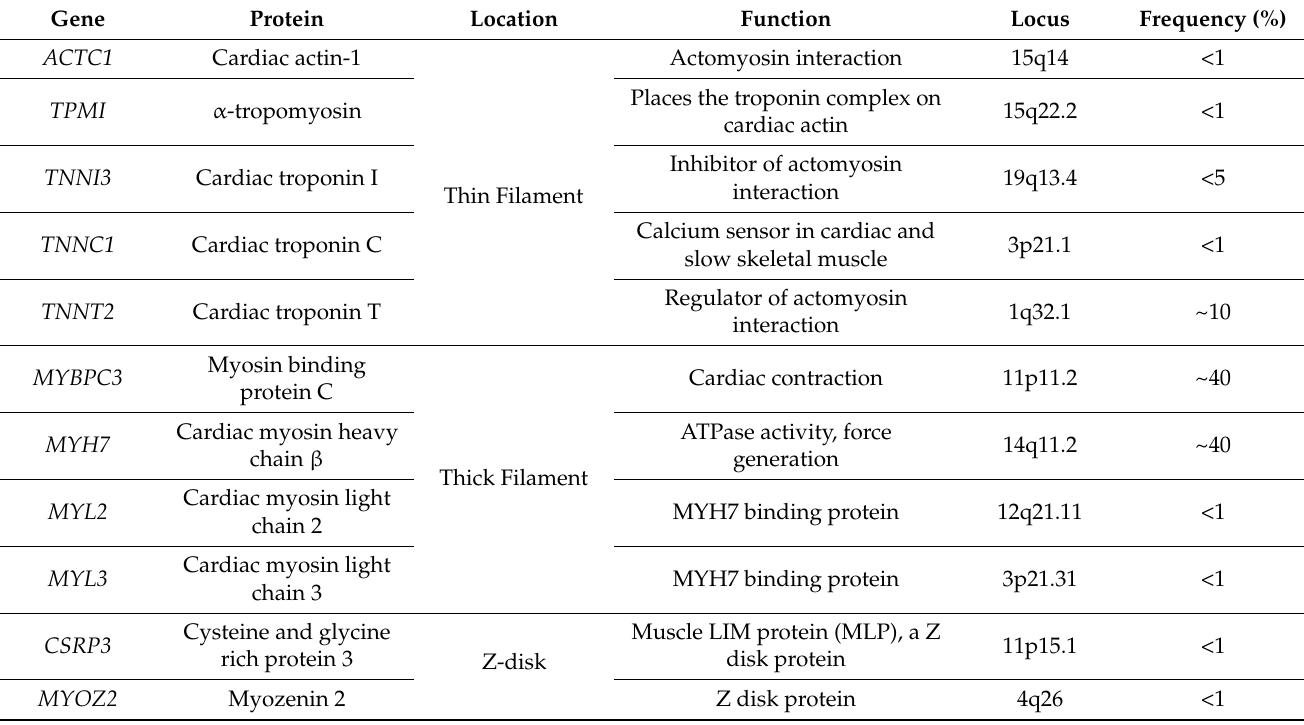
Table 1. List of genes implicated in hypertrophic cardiomyopathy.